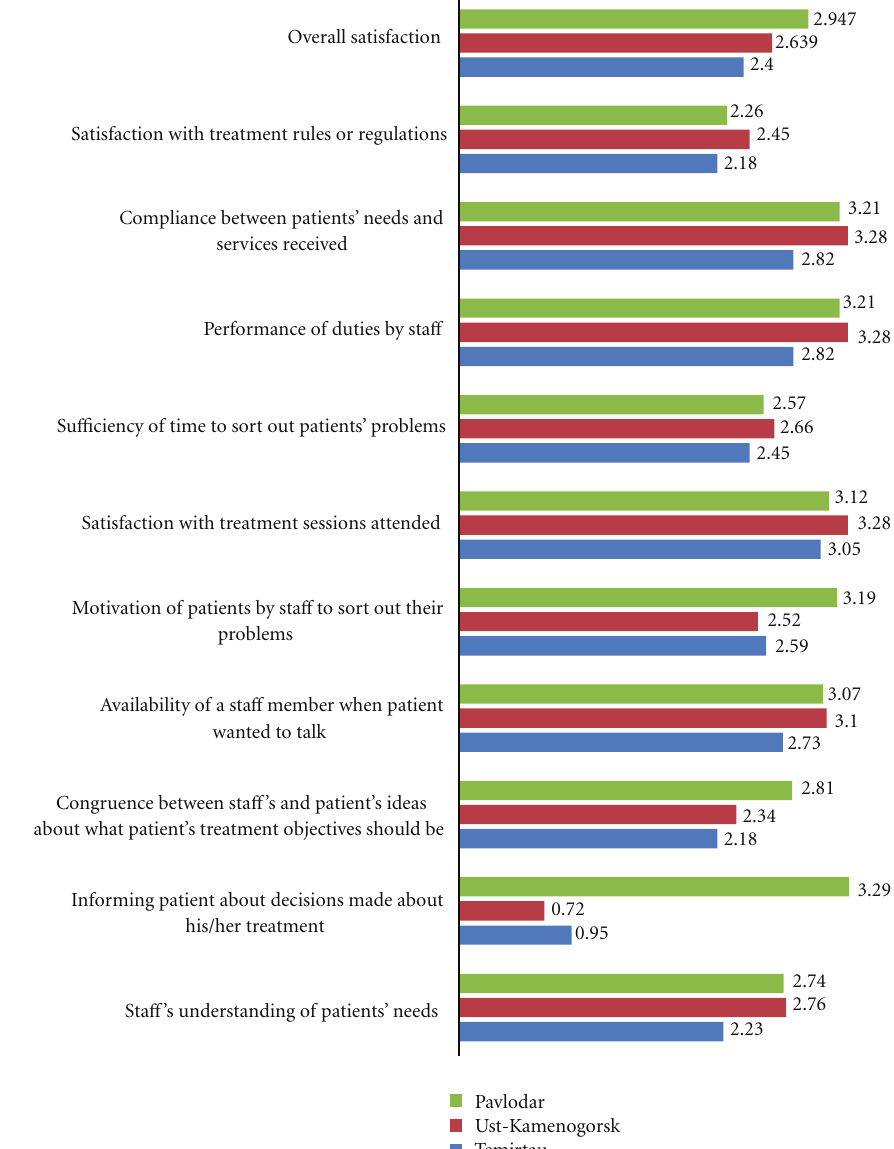
Figure 1: Clients’ satisfaction with medication-assisted treatment services in Kazakhstan as indicated by responses to the Treatment Perception Questionnaire. Mean scores are depicted, where 0 means strong dissatisfaction and 4 means strong satisfaction.